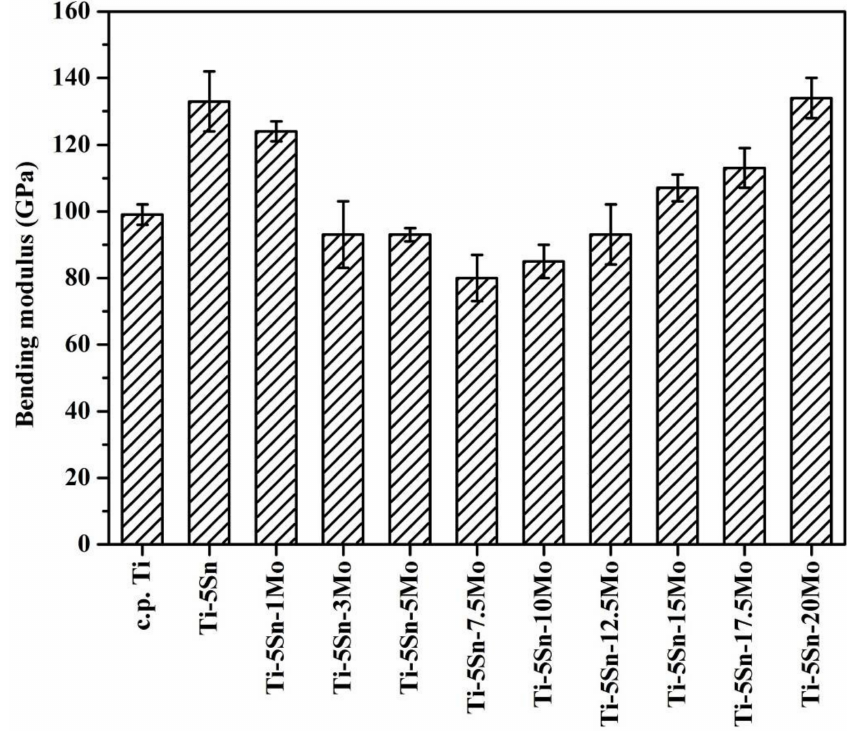
Figure 5. Bending moduli of as-cast c.p. Ti, Ti–5Sn, and Ti–5Sn– x Mo alloys.